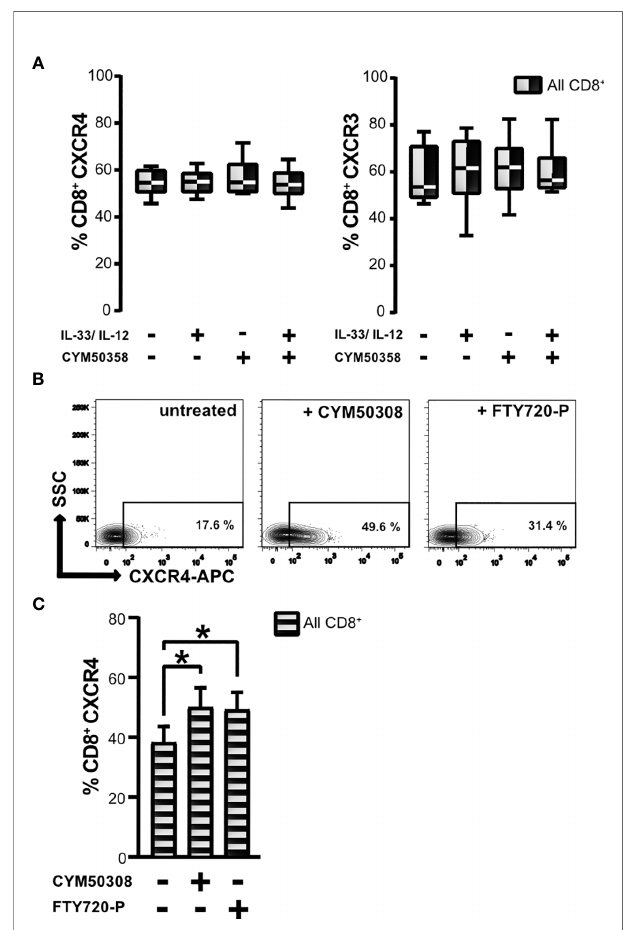
FIGURE 6 | Effects of S1P 4 receptor antagonist and FTY720-P on chemokine receptor expression. (A) CD8 + T lymphocytes were stimulated with IL-33 (20 ng/mL) in combination with IL-12 (5 ng/mL), and treated with the selective S1P 4 receptor antagonist CYM50358 (200 nM). Percentages of CXCR4 + (left) and CXCR3 + CD8 + T lymphocytes (right) are displayed as box plots which mark the 5 th percentile, the median and 95 th percentile. Data are obtained from n = 6 individual donors of three independent experiments. All comparisons showed no signi fi cance, using Friedman test with Dunn´s post- test. (B) Exemplary contour plots of FACS analysis for daily treatment of CD8 + T lymphocytes using either the selective S1P 4 receptor agonist (200 nM) or S1P receptor modulator FTY720-P (200 nM) compared to untreated control. (C) Frequencies of all CXCR4 + CD8 + T lymphocytes (shaded bars) after treatment with S1P 4 agonist (CYM50308) or fi ngolimod-phosphate (FTY720-P) compared to untreated control. Data are presented as mean ± SD from n = 8 donors of at least three independently performed experiments. *p ≤ 0.05, using Wilcoxon matched pairs signed rank